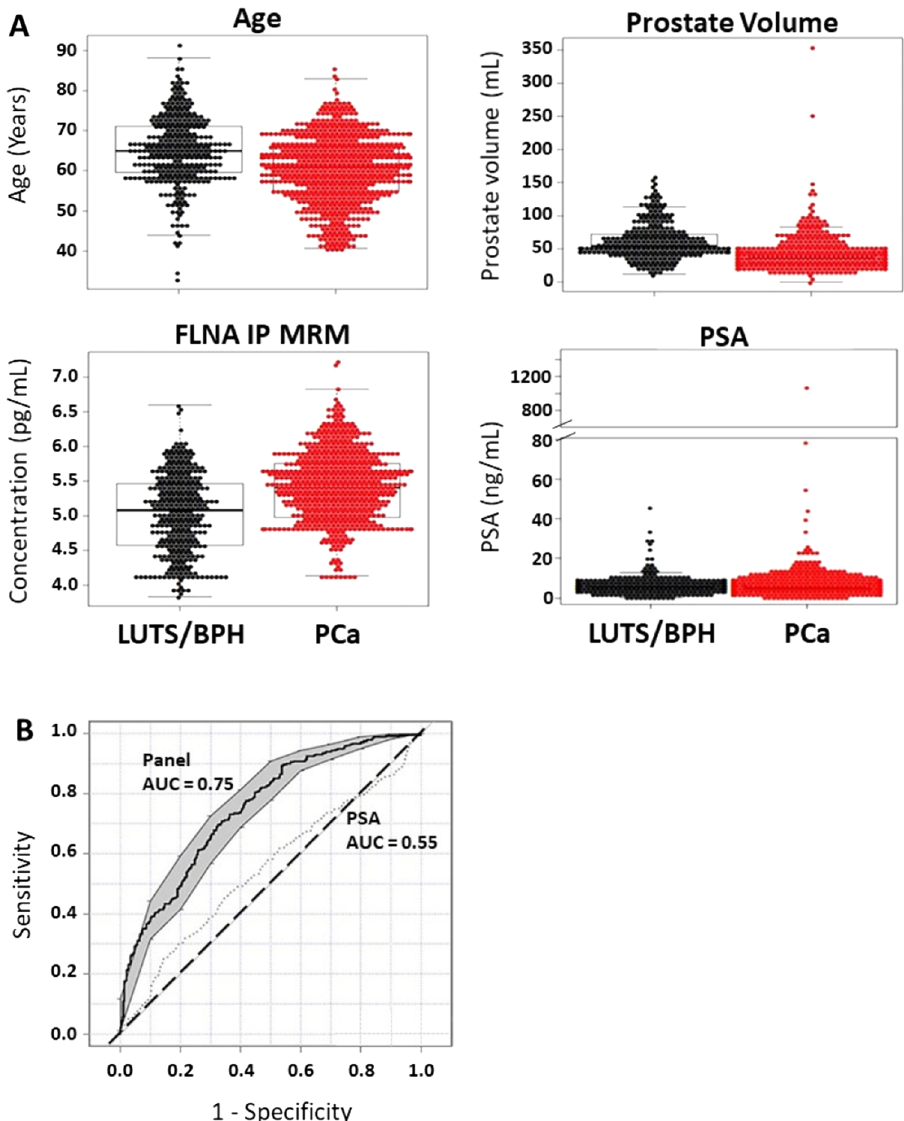
Figure 2. Prostate Cancer Biomarker Panel Performs Better Than PSA Alone in Differentiating Patients with Lower Urinary Tract Symptoms (LUTS) or Benign Prostate Hyperplasia (BPH) from Prostate Cancer (PCa). ( A ) Beeswarm and boxplot graphs showing median, interquartile range and distribution of age (years), prostate volume (mL), serum FLNA concentrations (pg/mL), and serum PSA concentrations (ng/mL) from patients with LUTS/BPH compared to those with PCa. Data represents n = 300 LUTS/BPH and n = 477 PCa. ( B ) Receiver operator characteristics (ROC) curve for prostate cancer biomarker panel demonstrates better performance in differentiating patients with LUTS/BPH from PCa compared to PSA alone. Area under the curve (AUC) for the panel is 0.75 versus PSA alone 0.55. Shaded grey regions indicate standard error.